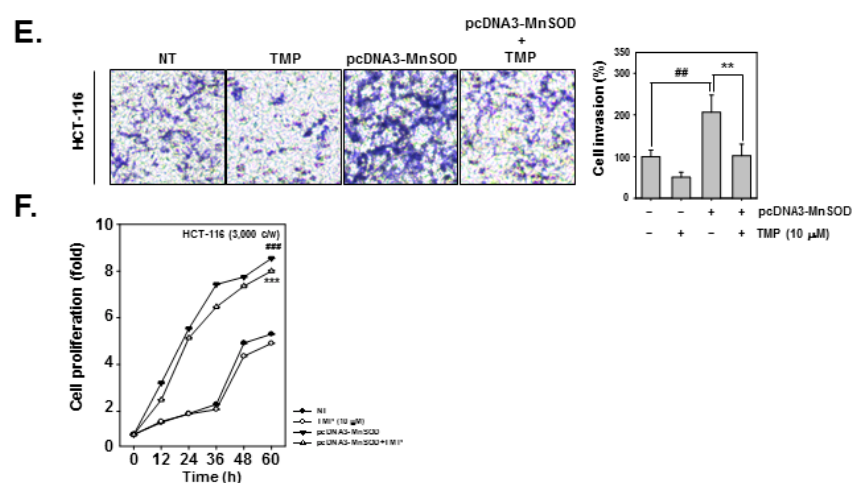
Figure 4. Effects of TMP on MnSOD overexpressed invasion, and migration in HCT-116 cells. HCT- 116 cells (5 × 10 4 cells/well) were transfected with pcDNA3-MnSOD for 24 h. ( A ) Then, cells were treated with TMP (10 μ M) for 24 h. Indicated EMT markers were evaluated by Western blot analysis. ( B ) The cells were treated with TMP (10 μ M) for 6 h, then PI3K/Akt/mTOR activation was analyzed by Western blot analysis. ( C , D ) TMP (10 μ M, 6 h) treated cells were evaluated Wnt/ β -catenin and MAPK signals by Western blot analysis. ( E ) Invasion activity of MnSOD overexpressed cells was evaluated by Boyden chamber assay. The cells were incubated for 5 h and stained in blue for observation. ( F ) MnSOD-overexpressed HCT-116 cells were treated with TMP (10 μ M), then cell proliferation was evaluated by RTCA. All the experiments were repeated at least thrice independently. ### p < 0.001 vs. non-treated (NT) cells, ## p < 0.01 vs. non-treated (NT) cells, and *** p < 0.001 vs. pcDNA3-MnSOD transfected cells. ** p < 0.01 vs. pcDNA3-MnSOD transfected cells.